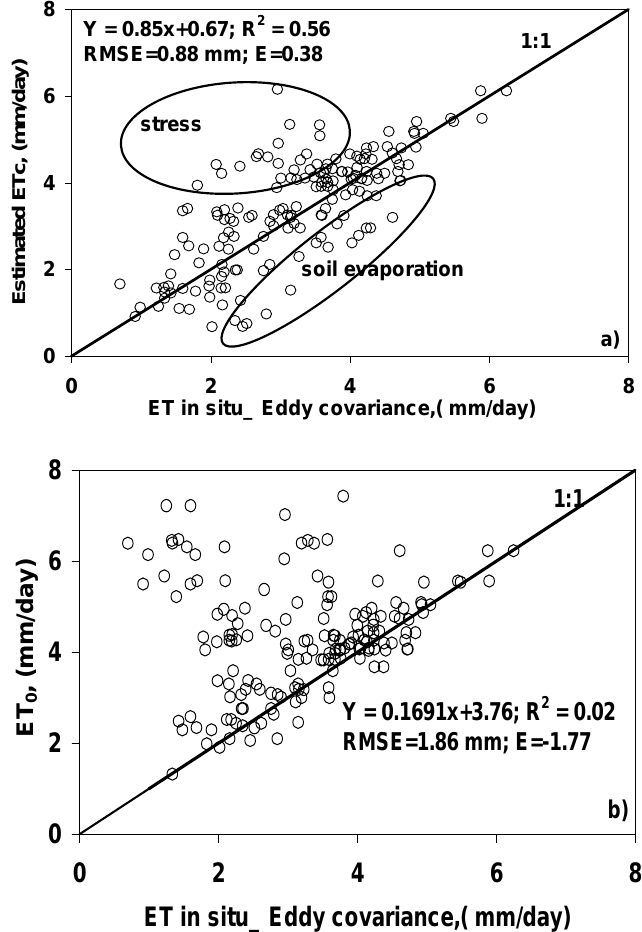
Figure 5. Scatter plot between daily estimated evapotranspiration (ET dual approach (Figure 5a), reference ET covariance technique over three fields of wheat in the Tensift basin (center of Morocco). The graph includes the 1:1